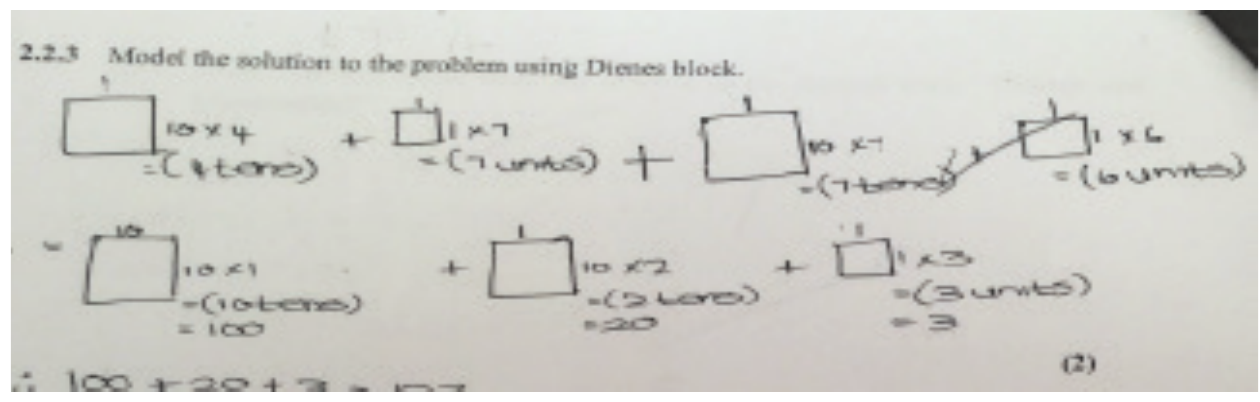
FIGURE 4: Sample of students’ written responses to item 4.